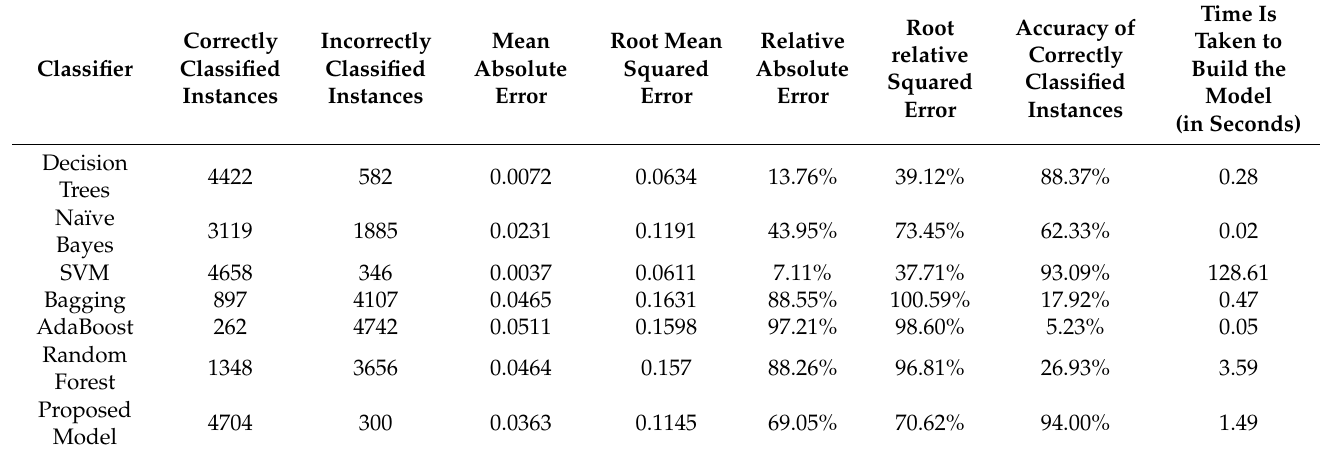
Table 3. Performances of various classifiers in COVID-19